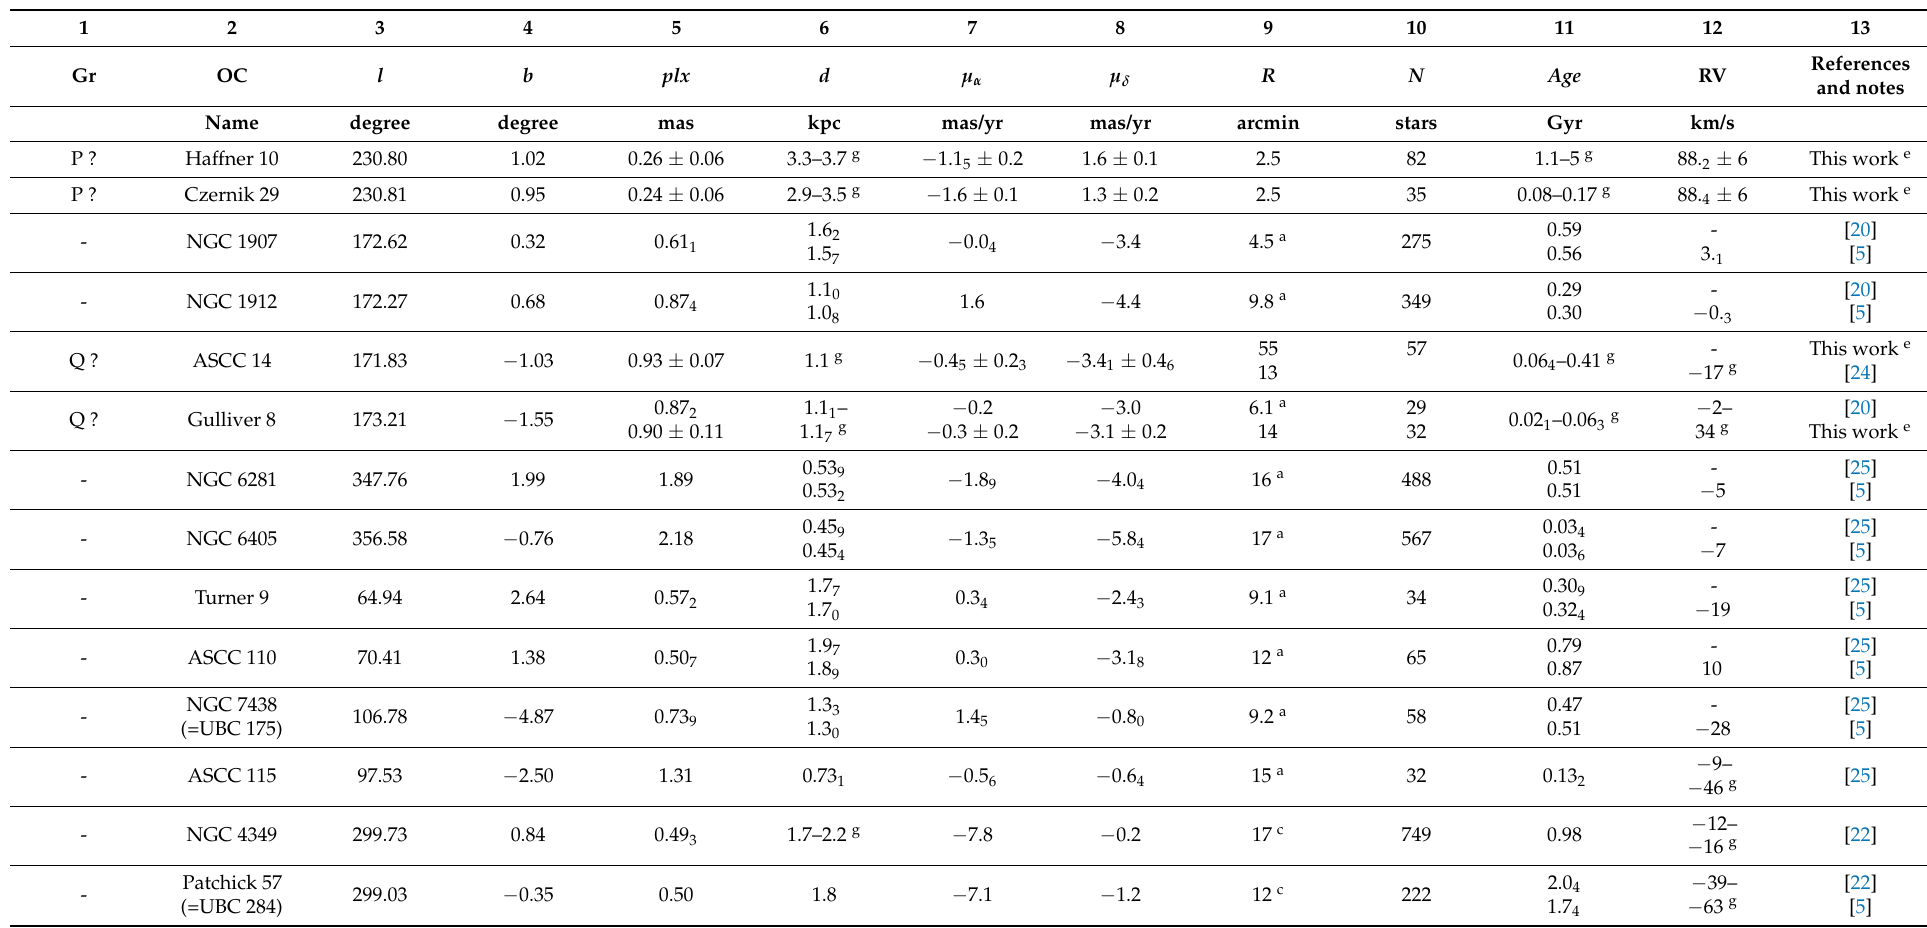
Table 1. Selected possible OC groups (Gr) and candidate member’s properties studied in this work. Column headings: 1. Group label; 2. OC name; 3. Galactic longitude; 4. Galactic latitude; 5. Parallax; 6. Photometric Distance; 7. PM in right ascension; 8. PM in declination; 9. OC radius; 10. Number of member stars; 11. Age; 12. Radial velocity. Abbreviations: a radius containing 50% of members; c maximum cluster member’s distance to average position; e reexamined using Gaia EDR3 due to insufficient, imprecise or inconsistent reports; f too few stars for a complete characterization; g see text; p protocluster or embedded cluster; ?